Question: Name the type of graph shown.
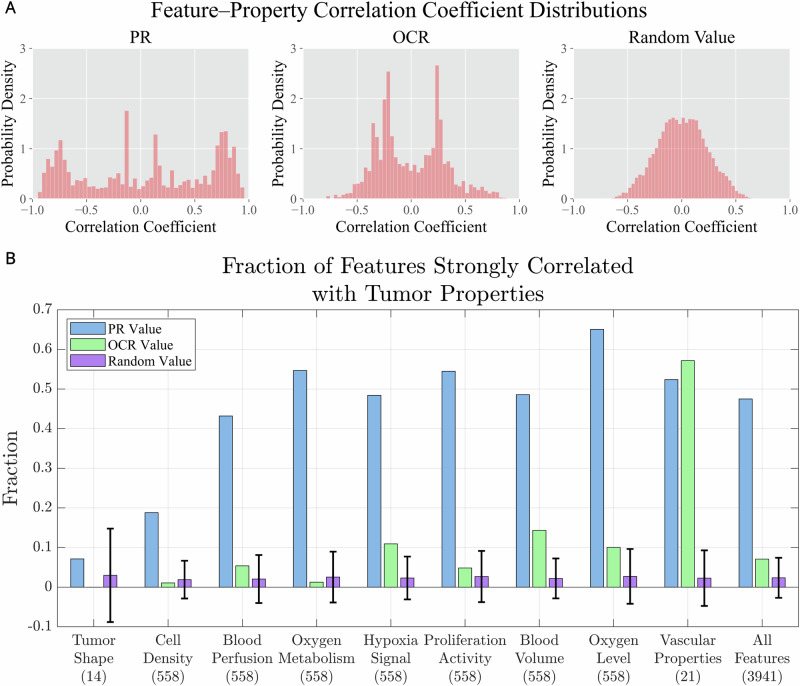
Answer: line